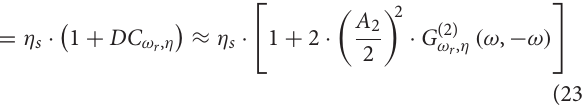
Frontiers in Chemistry |